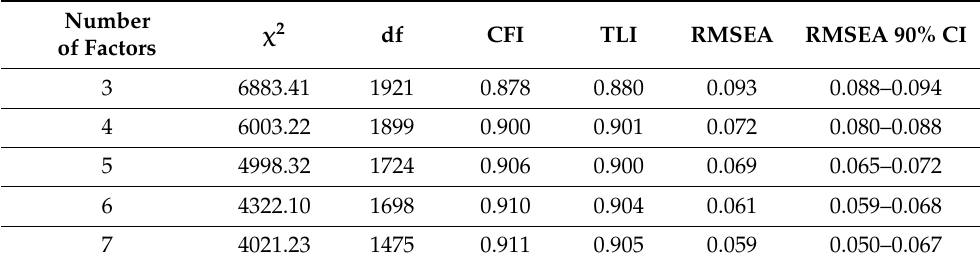
Table 10. Comparison of Factors’